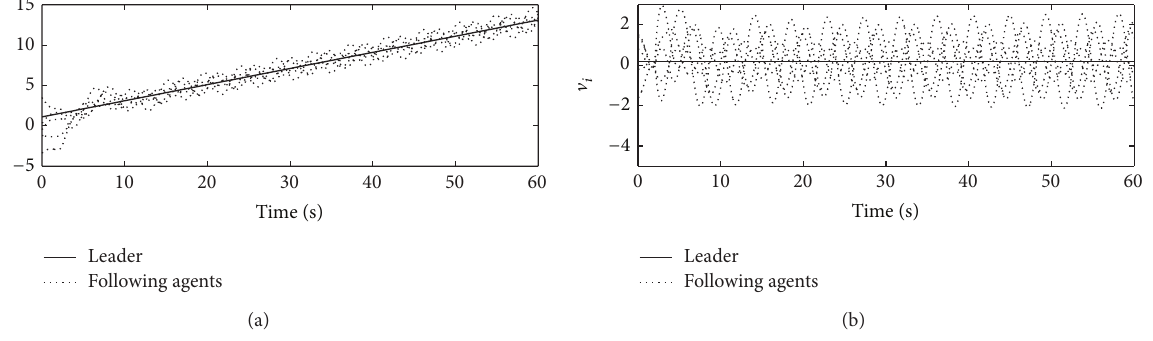
Figure 5: Oscillation of agents’ states.